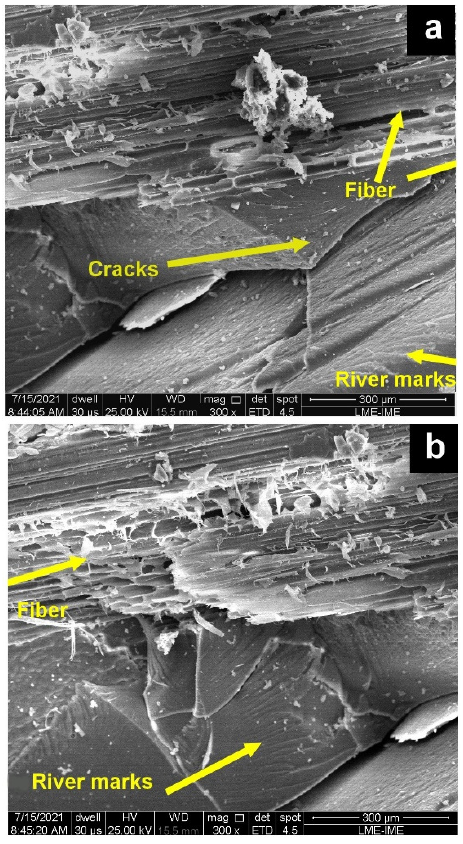
Figure 8. SEM images of 30 vol% epoxy-caranan composites after ballistic testing ( a ) fractured surfaces ( b ) river marks in epoxy matrix.